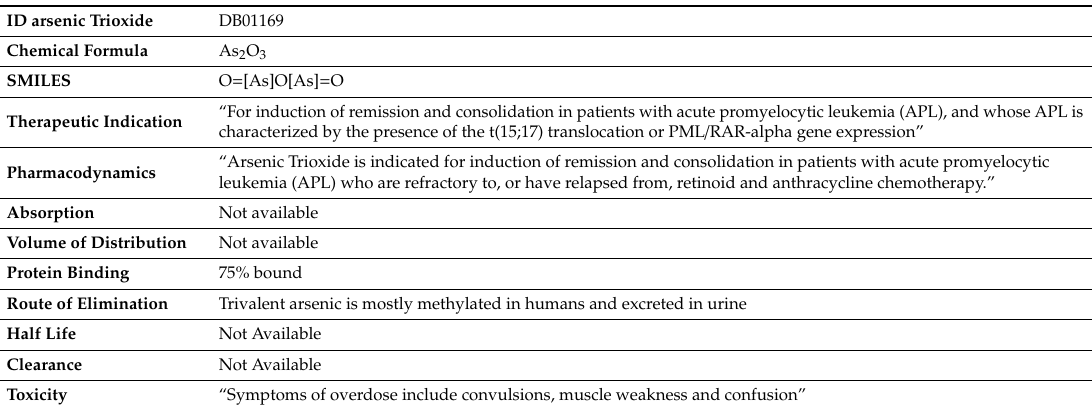
Table 3. Structural, functional, and pharmacokinetic data of arsenic trioxide extracted from the DrugBank database